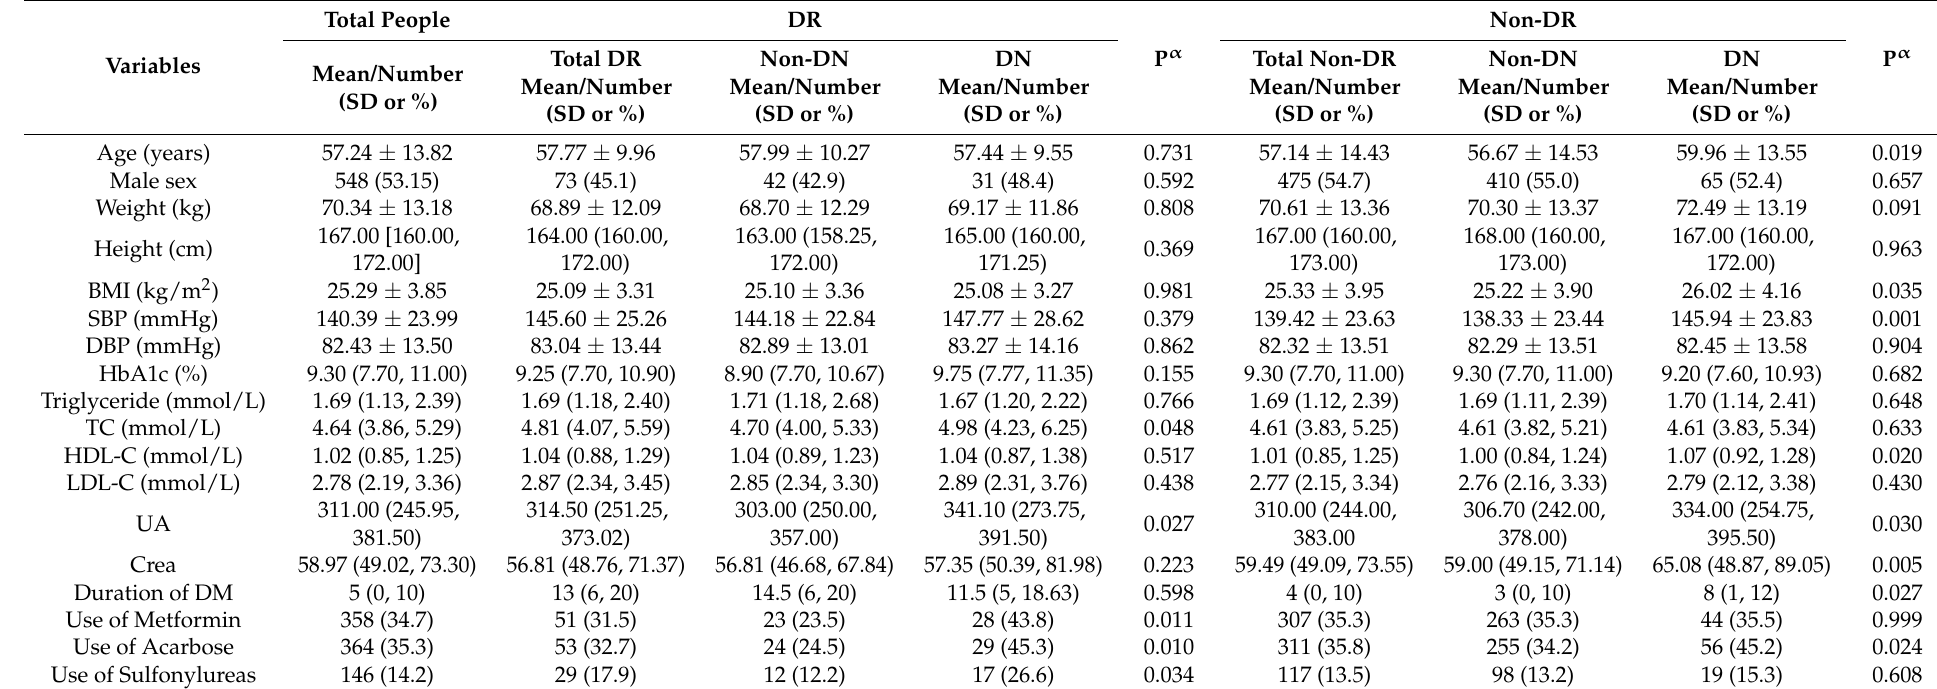
Table 1. Clinical and biochemical characteristics of participants according to the occurrence of